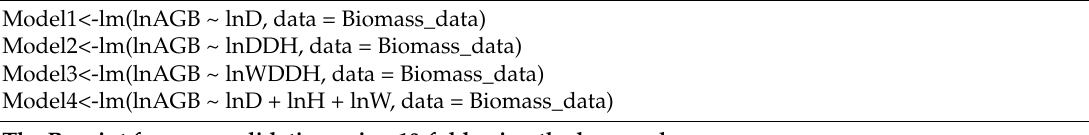
Table A3. R scripts for the four models.